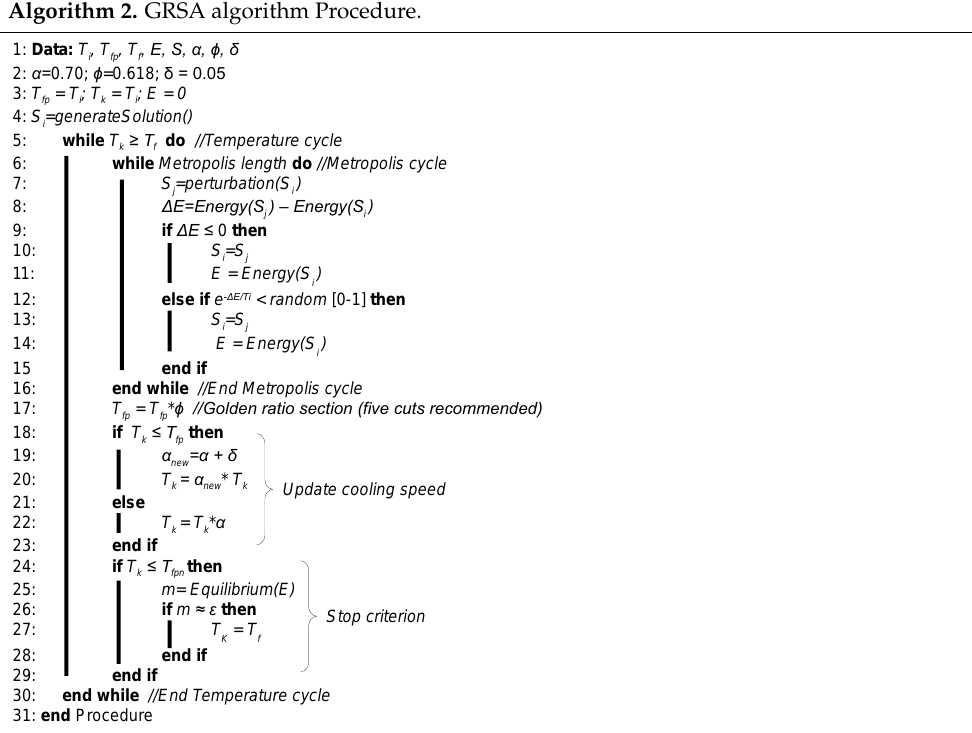
Algorithm 3. Equilibrium Function. Algorithm 2.1 Equilibrium Function 1: